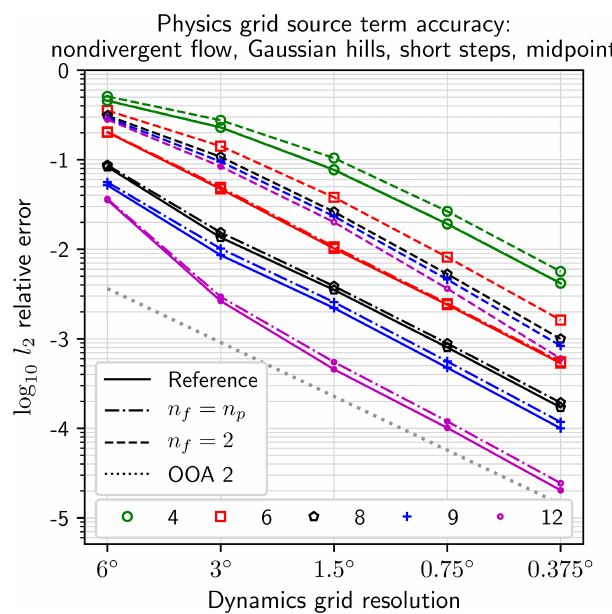
Figure 15. Verification of the remap of tendencies from physics to tracer grids and state from tracer to dynamics grids. See Sect. 4.3 for a description of the problem.